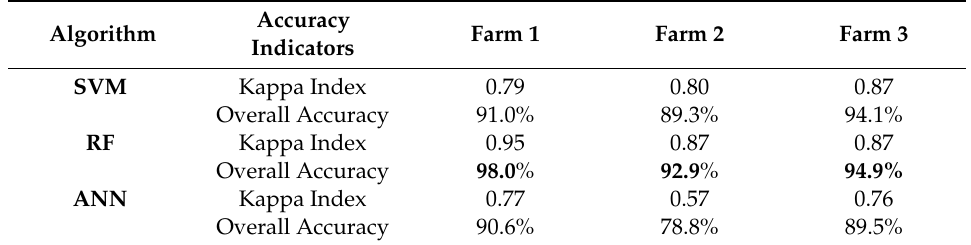
Table 4. Kappa Index and Overall Accuracy from Random Forest (RF), Support Vector Machine (SVM), and Artificial Neural Networks (ANN) algorithms using multitemporal classification applied to the three